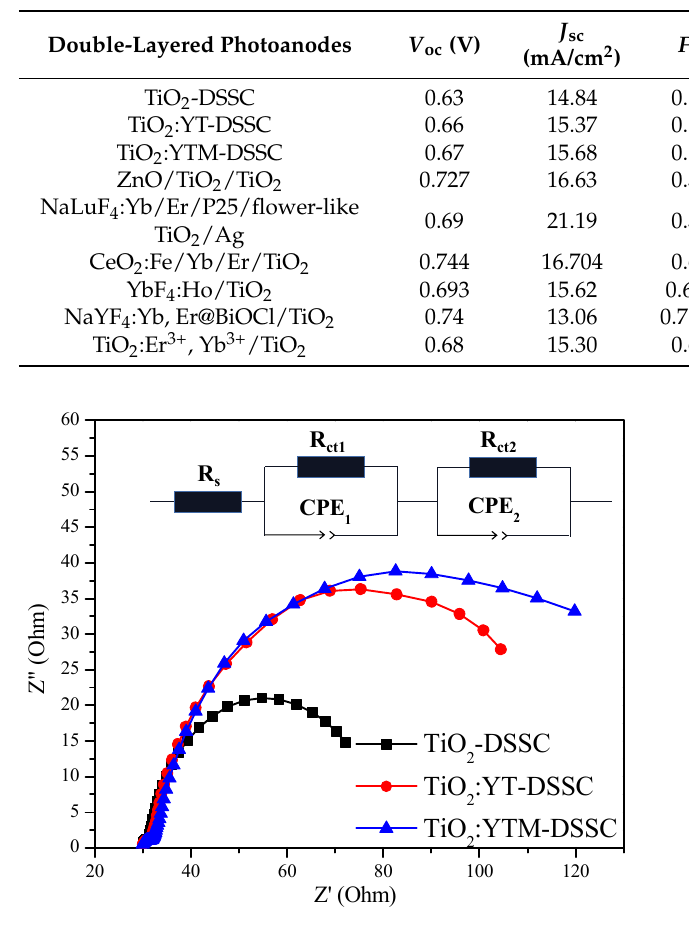
Figure 6. Nyquist curve of TiO 2 -DSSC and TiO 2 :YTM-DSSC.